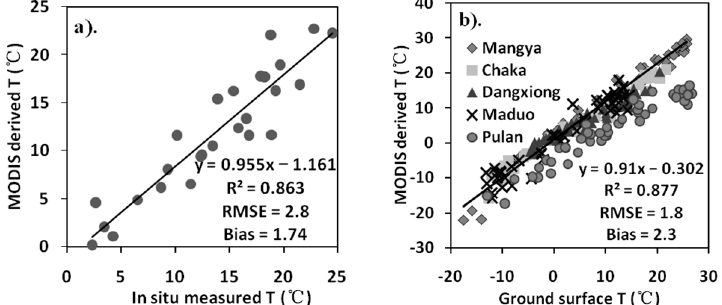
Figure 2. MODIS land surface temperature (LST) product validation with both in situ measured data ( a ); and meteorological data ( b ) were collected in five different stations while in situ data were measured in 15 lakes across the Tibetan Plateau in 2014 and 2015.